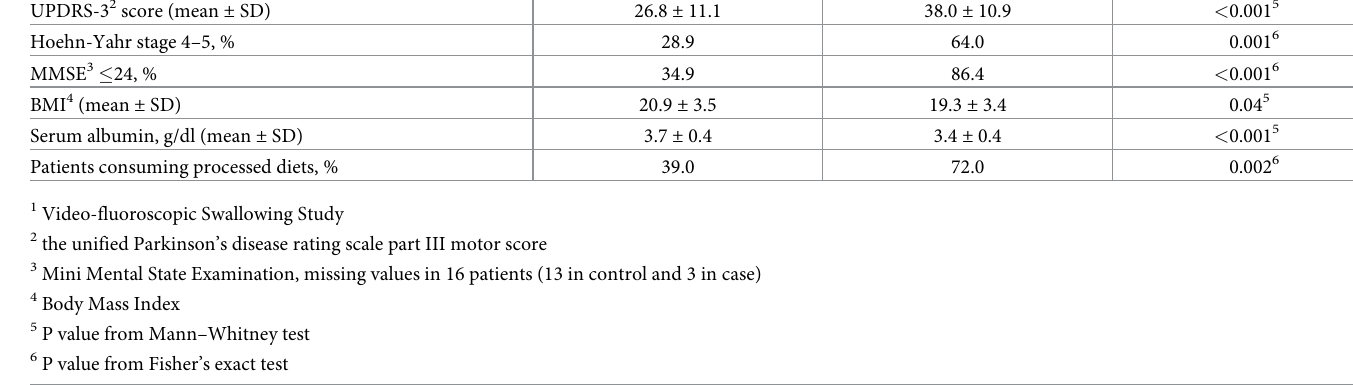
disease duration between the two groups. Compared with the controls, the cases had signifi-